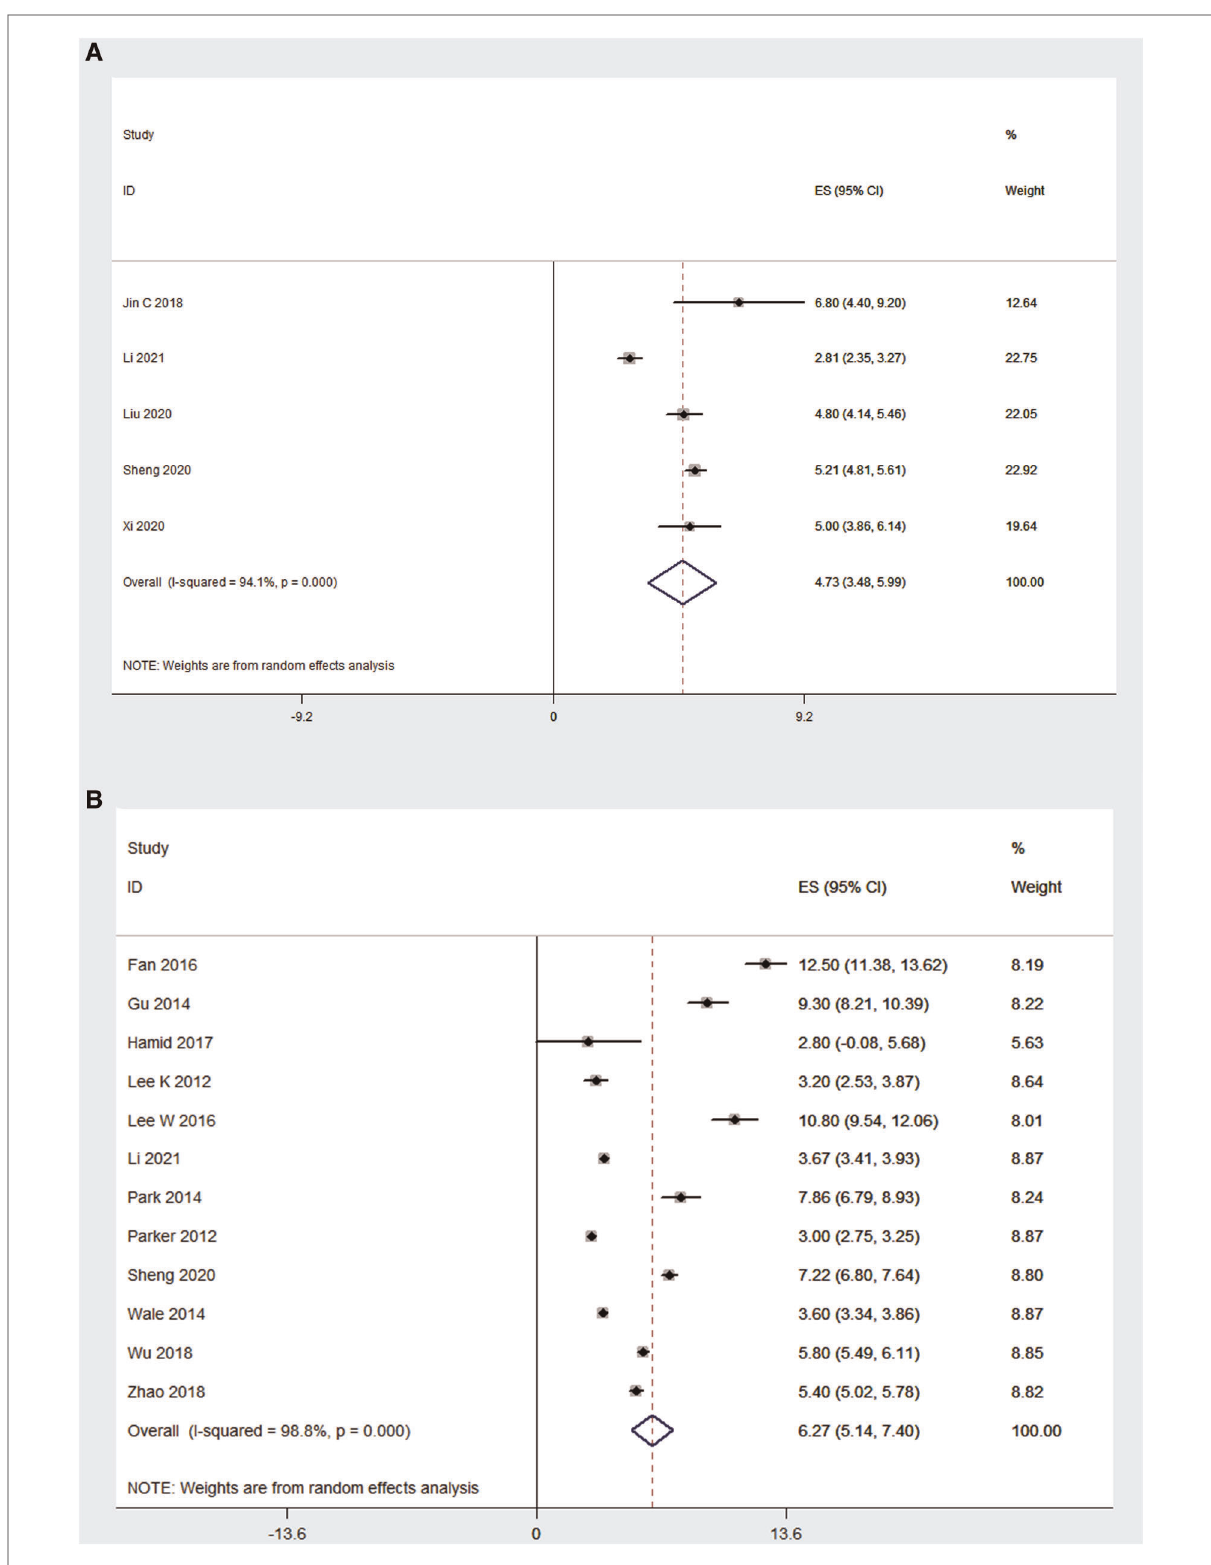
FIGURE 2 Forest plot and pooled estimates of the length of hospital stay. Outcomes assessed are ( A ) OLIF group; ( B ) MI-TLIF